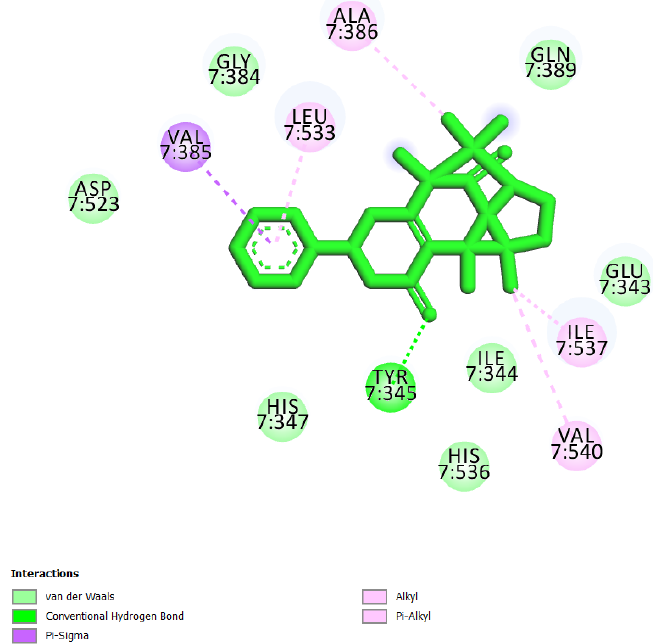
Figure 2. MCM7 protein-interacting residues with UEFS137. Different color codes represent the residual interaction types.